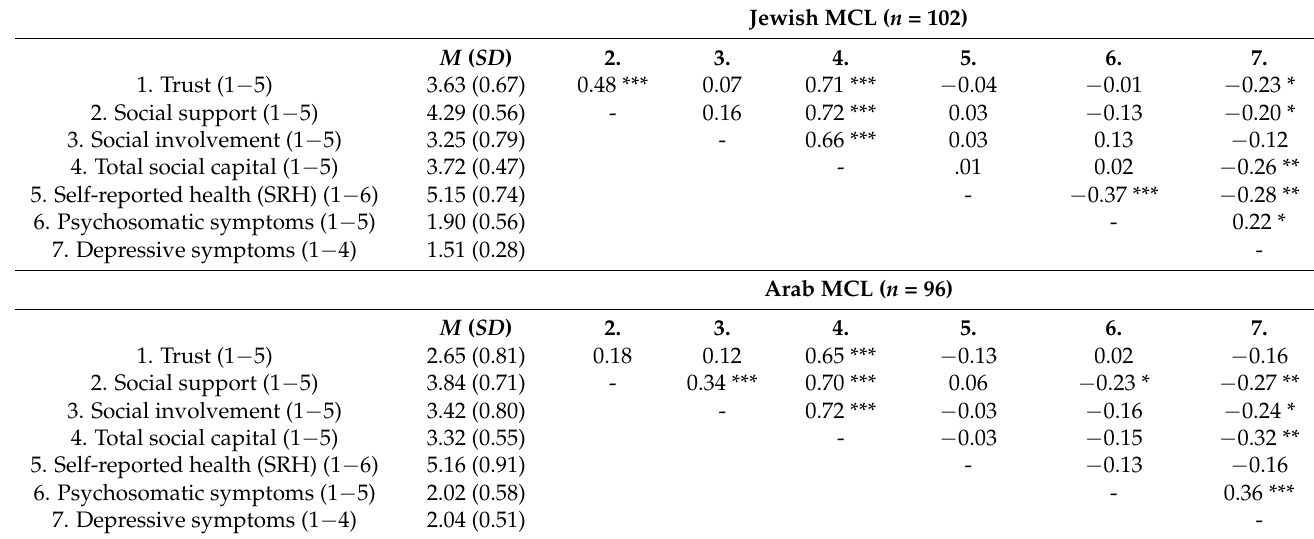
Table 2. Mean scores and correlations between the study variables among MCL participants, by